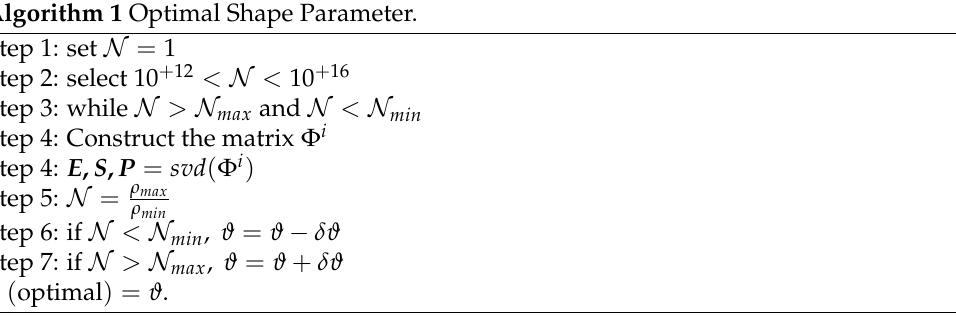
Algorithm 1 Optimal Shape